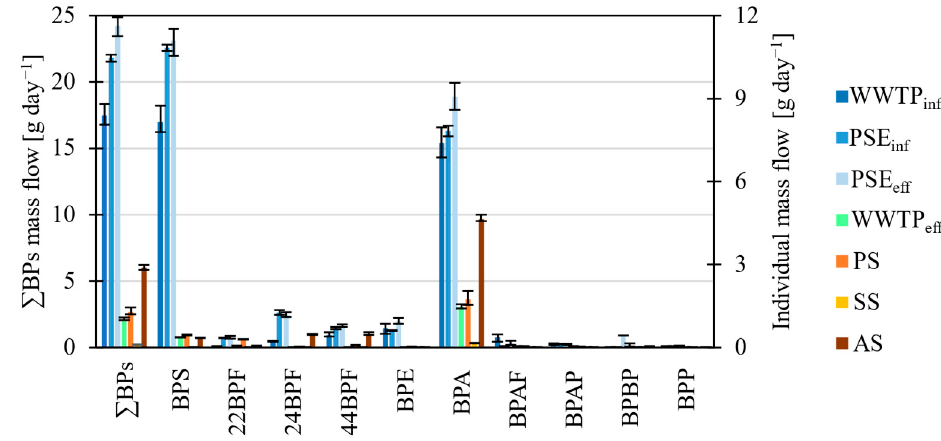
Figure 5. Histogram of mass flows of BPs in the selected wastewater flows and sludge.